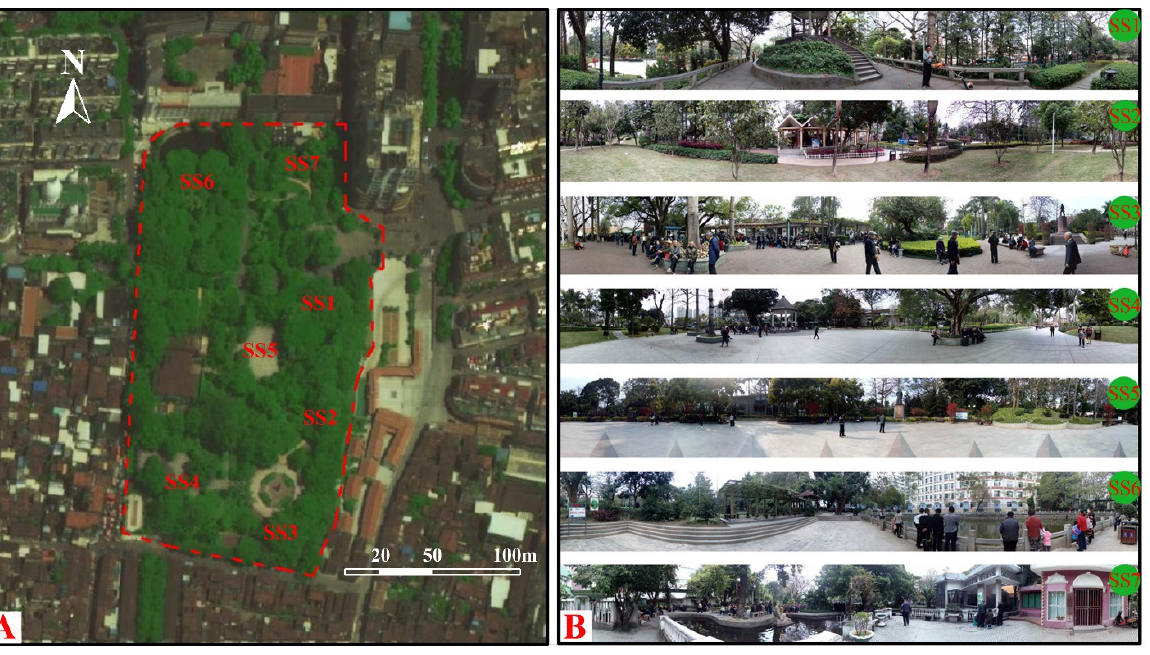
Figure 1. Park image from Amap (source: http://ditu.amap.com; accessed on 20 January 2020) (A) and panoramic photos of seven sample sites in Zhongshan Park (B).